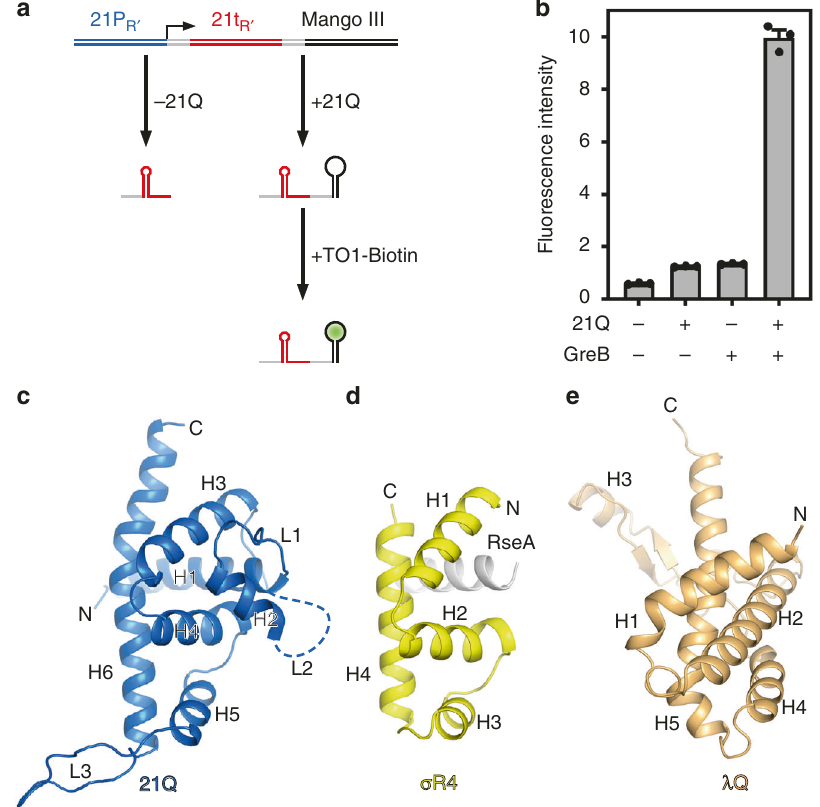
Fig. 1 Crystal structure of 21Q. a Principle of Mango III transcription antitermination assay. b 21Q-dependent antitermination is boosted by GreB (mean ± SEM; 3 determinations). c Crystal structure of 21Q. The disordered region of L2 is denoted as a dashed loop. d Crystal structure of σ R4 in complex with anti- σ RseA (PDB 1OR7 [10.2210/pdb1OR7/pdb]). Yellow, σ R4; gray, RseA. e Crystal structure of N-terminal truncated λ Q (PDB 4MO1 https://doi.org/ 10.2210/pdb4MO1/pdb). Error bars represent mean ± SEM out of n = 3 experiments. Source data are provided as a Source Data fi